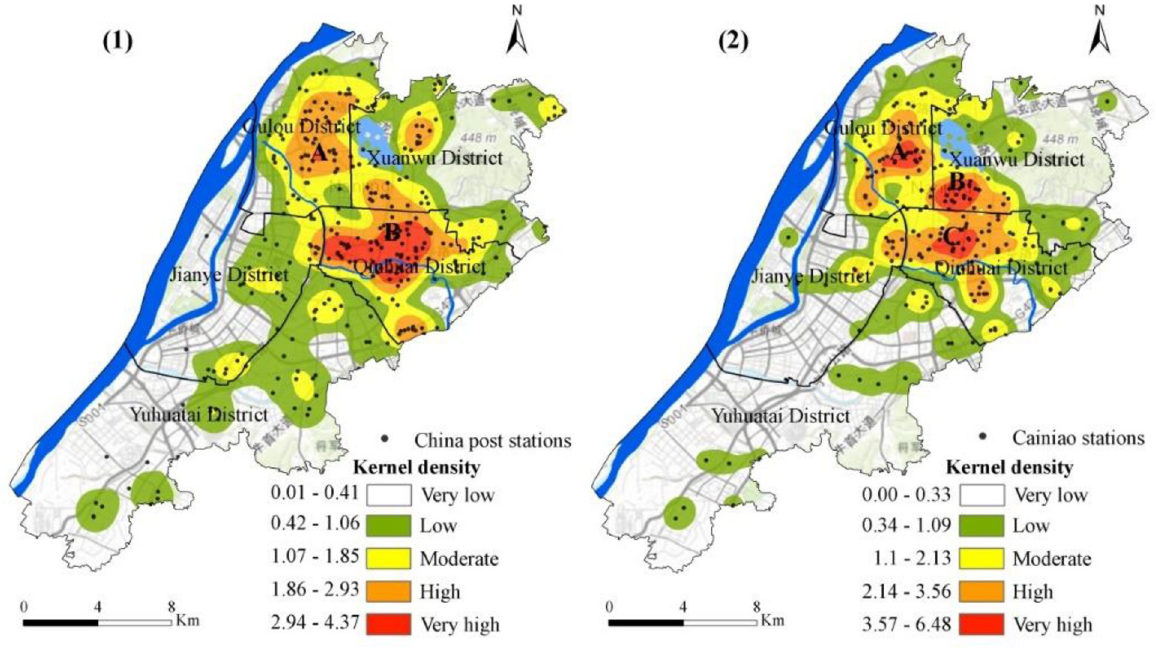
Fig 6. Spatial KDE distribution of CDPs in downtown Nanjing